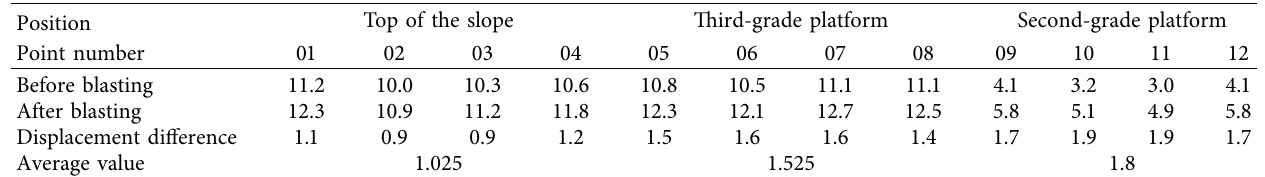
Figure 12: Displacement measurement point layout. Table 3: Accumulated displacement change before and after blasting (unit: mm).